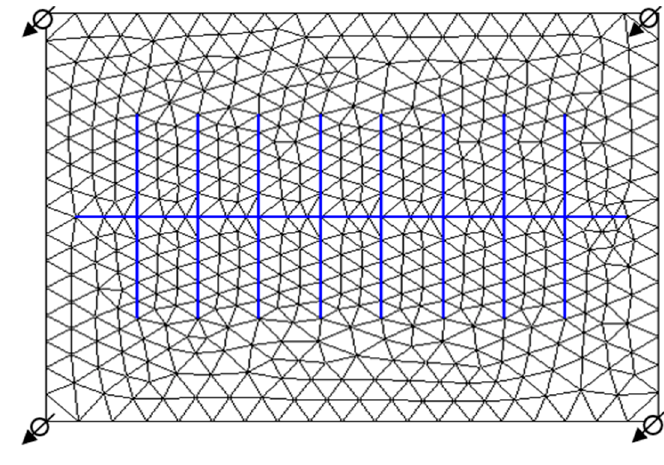
Figure 4. Scheme of staggered five spot water-injection model.